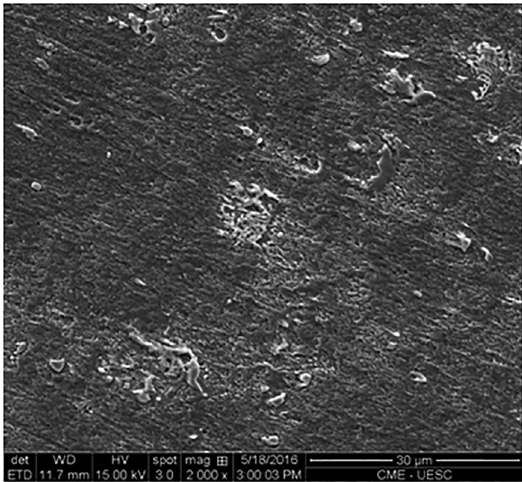
Figure 8. SEM micrograph of AISI 1020 carbon steel after 2 h immersion in HCl 0.5 mol.L -1 . Figure 10 shows the substrate surface after 12 h of immersion in the absence of inhibitor. It can be seen a higher degree of attack in comparison with Figure 8 (2 hours of immersion). However, in the presence of castor bark powder (Figure 11), even with the high time of exposure, the substrate surface was less attacked than in absence of inhibitor, presenting few corrosion products, indicating the inhibitory property of the castor bark